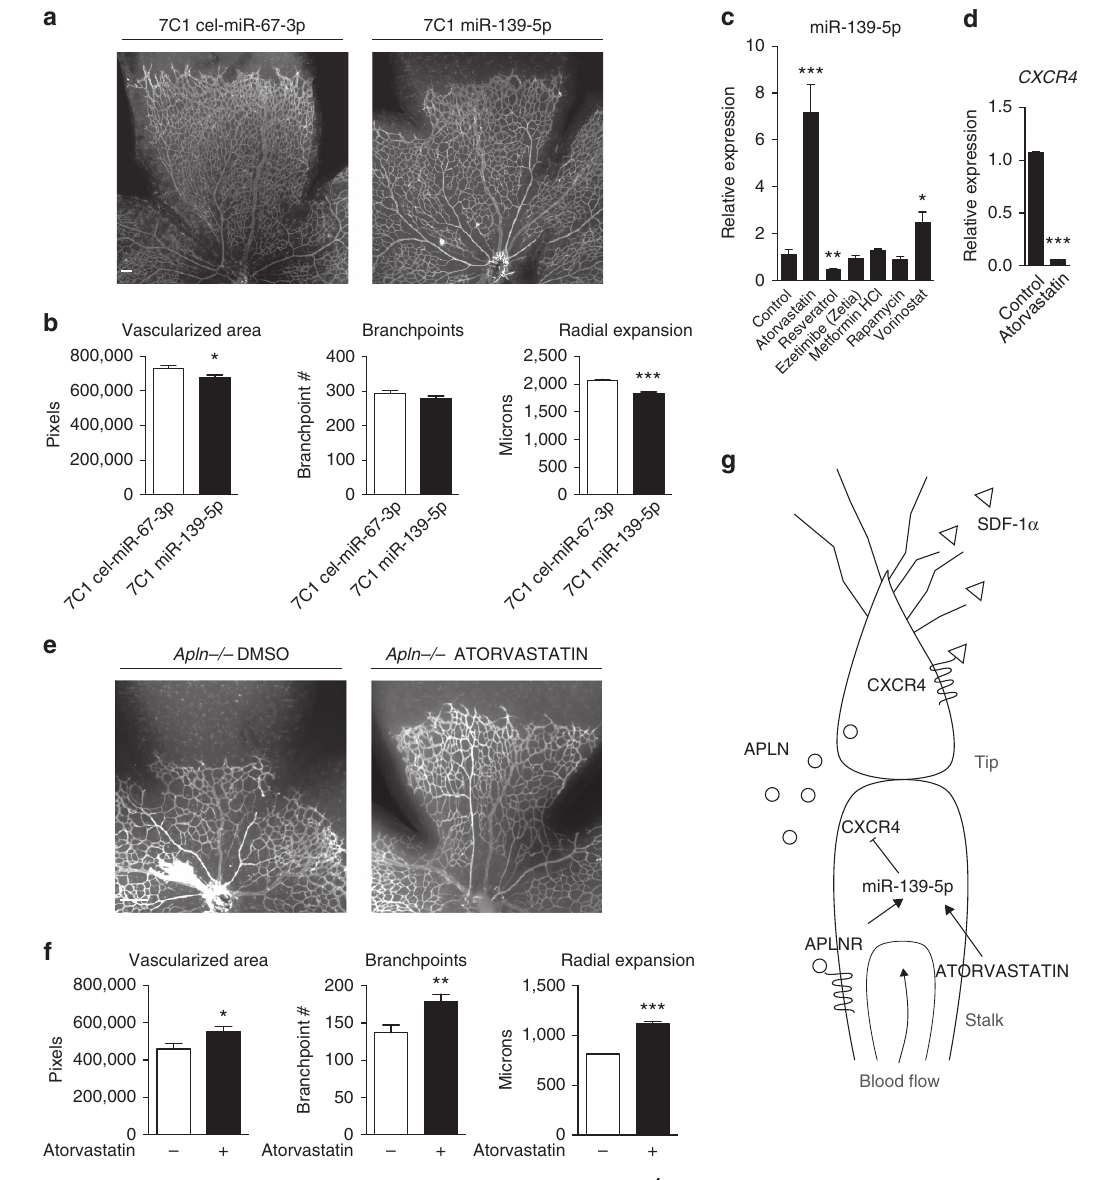
Figure 4 | Atorvastatin augments apelin/APLNR signalling and improves the Apln (cid:2) / (cid:2) retinal phenotype. ( a , b ) In vivo inhibition of miR-139-5p postnatally with 7C1 nanoparticles loaded with anti-miR to miR-139-5p results in reduced vascularized area and radial expansion of retinal vasculature at P5. n ¼ 6 retinas per genotype. ( c ) Drug screen using clinically approved compounds that affect miR-139-5p expression levels in HUVECs. n ¼ 3 experiments. ( d ) CXCR4 mRNA expression in HUVECs in response to atorvastatin stimulation. n ¼ 3 experiments. ( e , f ) P5 retinal phenotype of Apln (cid:2) / (cid:2) pups in response to treatment with atorvastatin. Vascularized area, vascular branchpoints and radial expansion are shown. Scale bar, 200 m m. n Z 4 retinas per genotype. ( g ) Schematic representation of the proposed signalling cascade between APLNR, CXCR4 and the respective ligands in the developing vasculature. * P o 0.05, ** P r 0.01, *** P r 0.001, t- test. Error bars represent s.e.m. NATURE COMMUNICATIONS|7:11268|DOI: